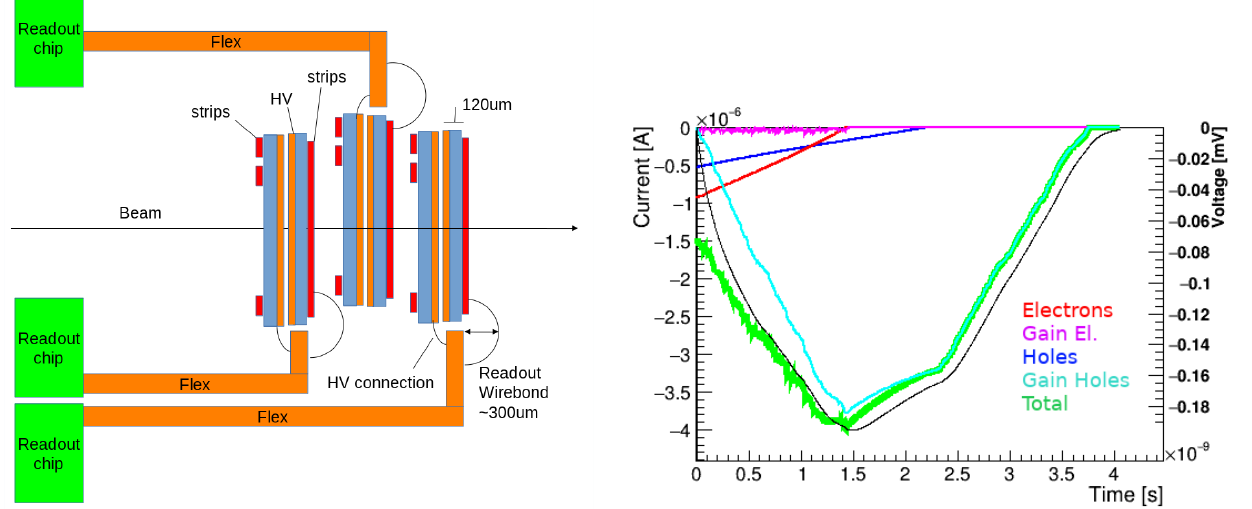
Figure 3. ( Left ) Concept schematic design of the ATAR, side view. The flex from the first, third, and fifth sensors is directed in and out of the page. The modules are attached on the HV side and with a few µ m of separation on the strip side. The flex to the readout chip is roughly 5 cm long. The total number of sensors is 48, coupled in 24 pairs. ( Right ) Simulated 120 µ m thick LGAD pulse shape for a MiP (weightfield2 [25]). The black line is the response of a 2 GHz bandwidth electronic